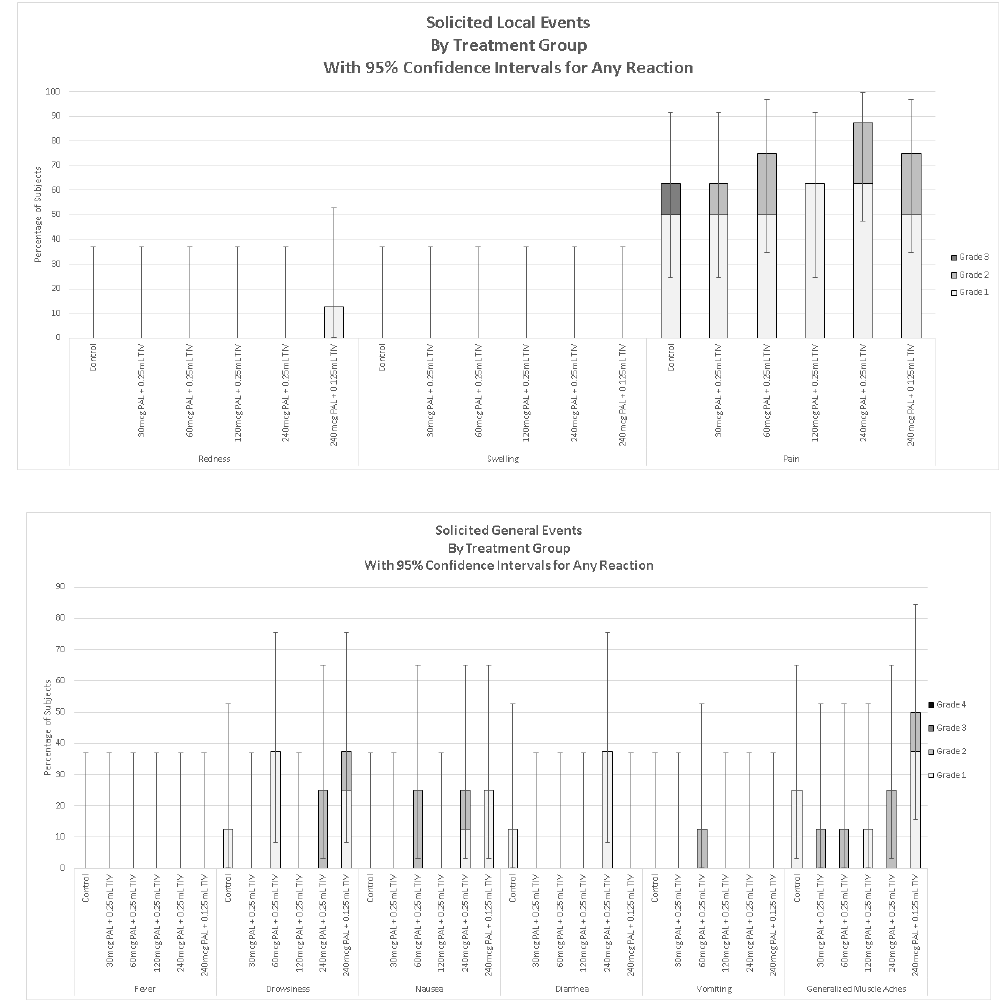
Figure 2. Solicited local and systemic adverse events in the seven days after vaccination. Legend.